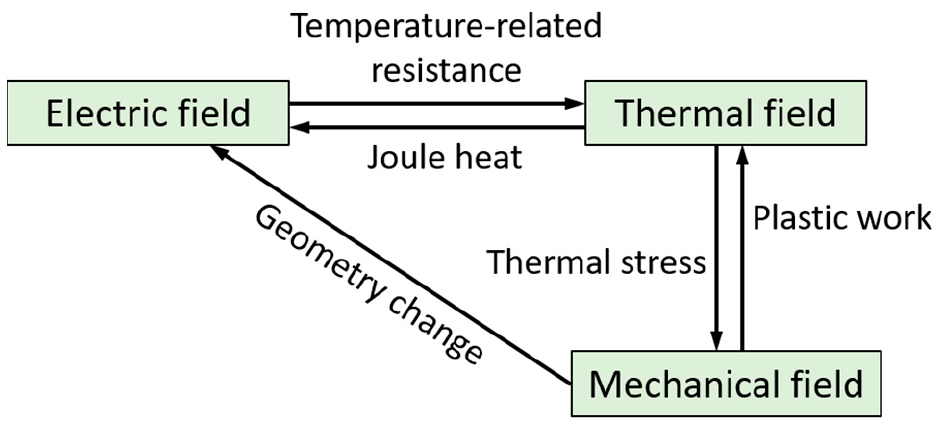
Figure 3. Schematic illustration of the complicated interrelationships between electric, thermal and mechanical fields.